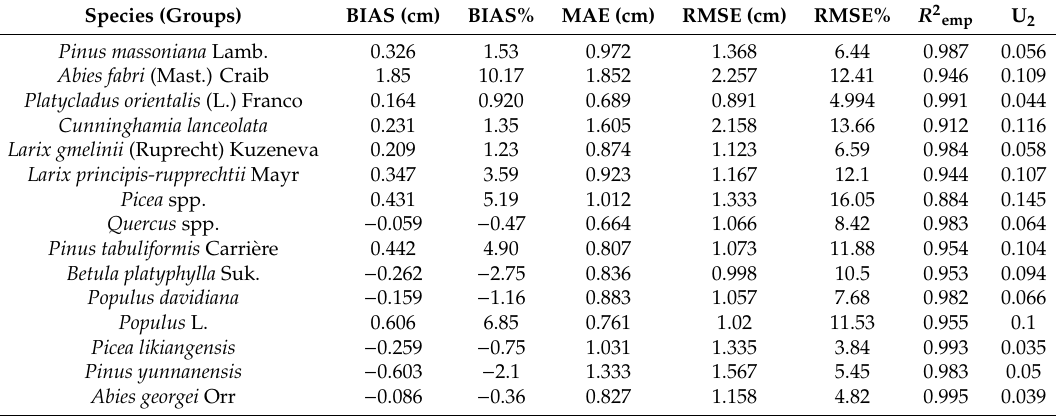
Table 6. Validation precision of the tree diameter at breast height (DBH) di ff erence equations for di ff erent tree